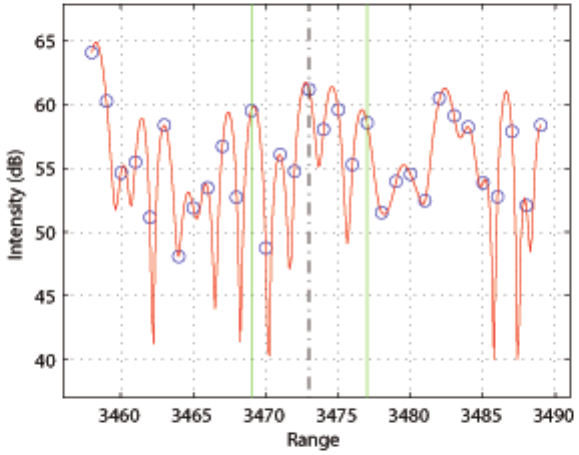
Figure 3. Corner reflector HV response (in range).